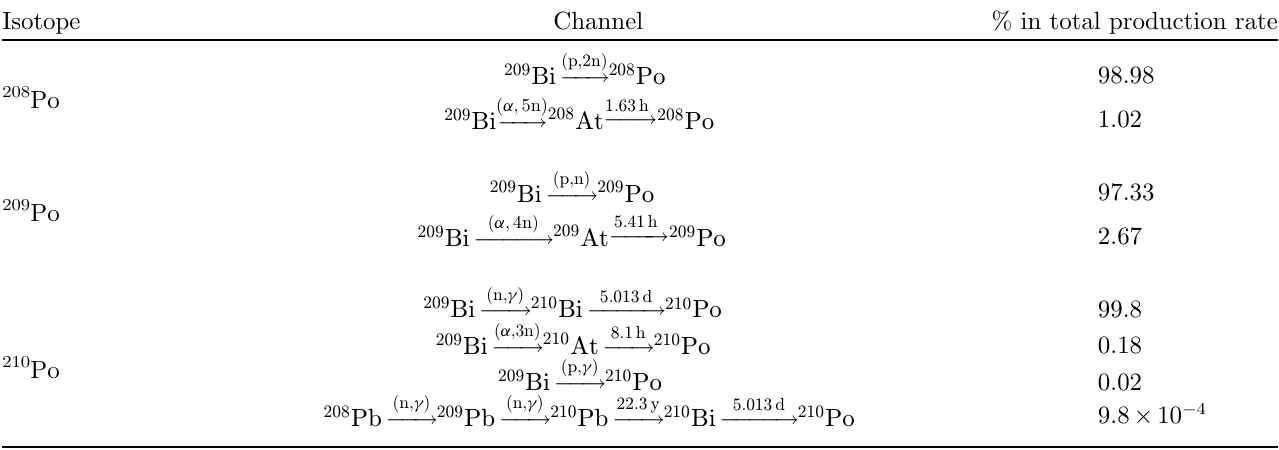
Table 1. Different channels for the polonium production in the spallation target of MYRRHA. Isotope